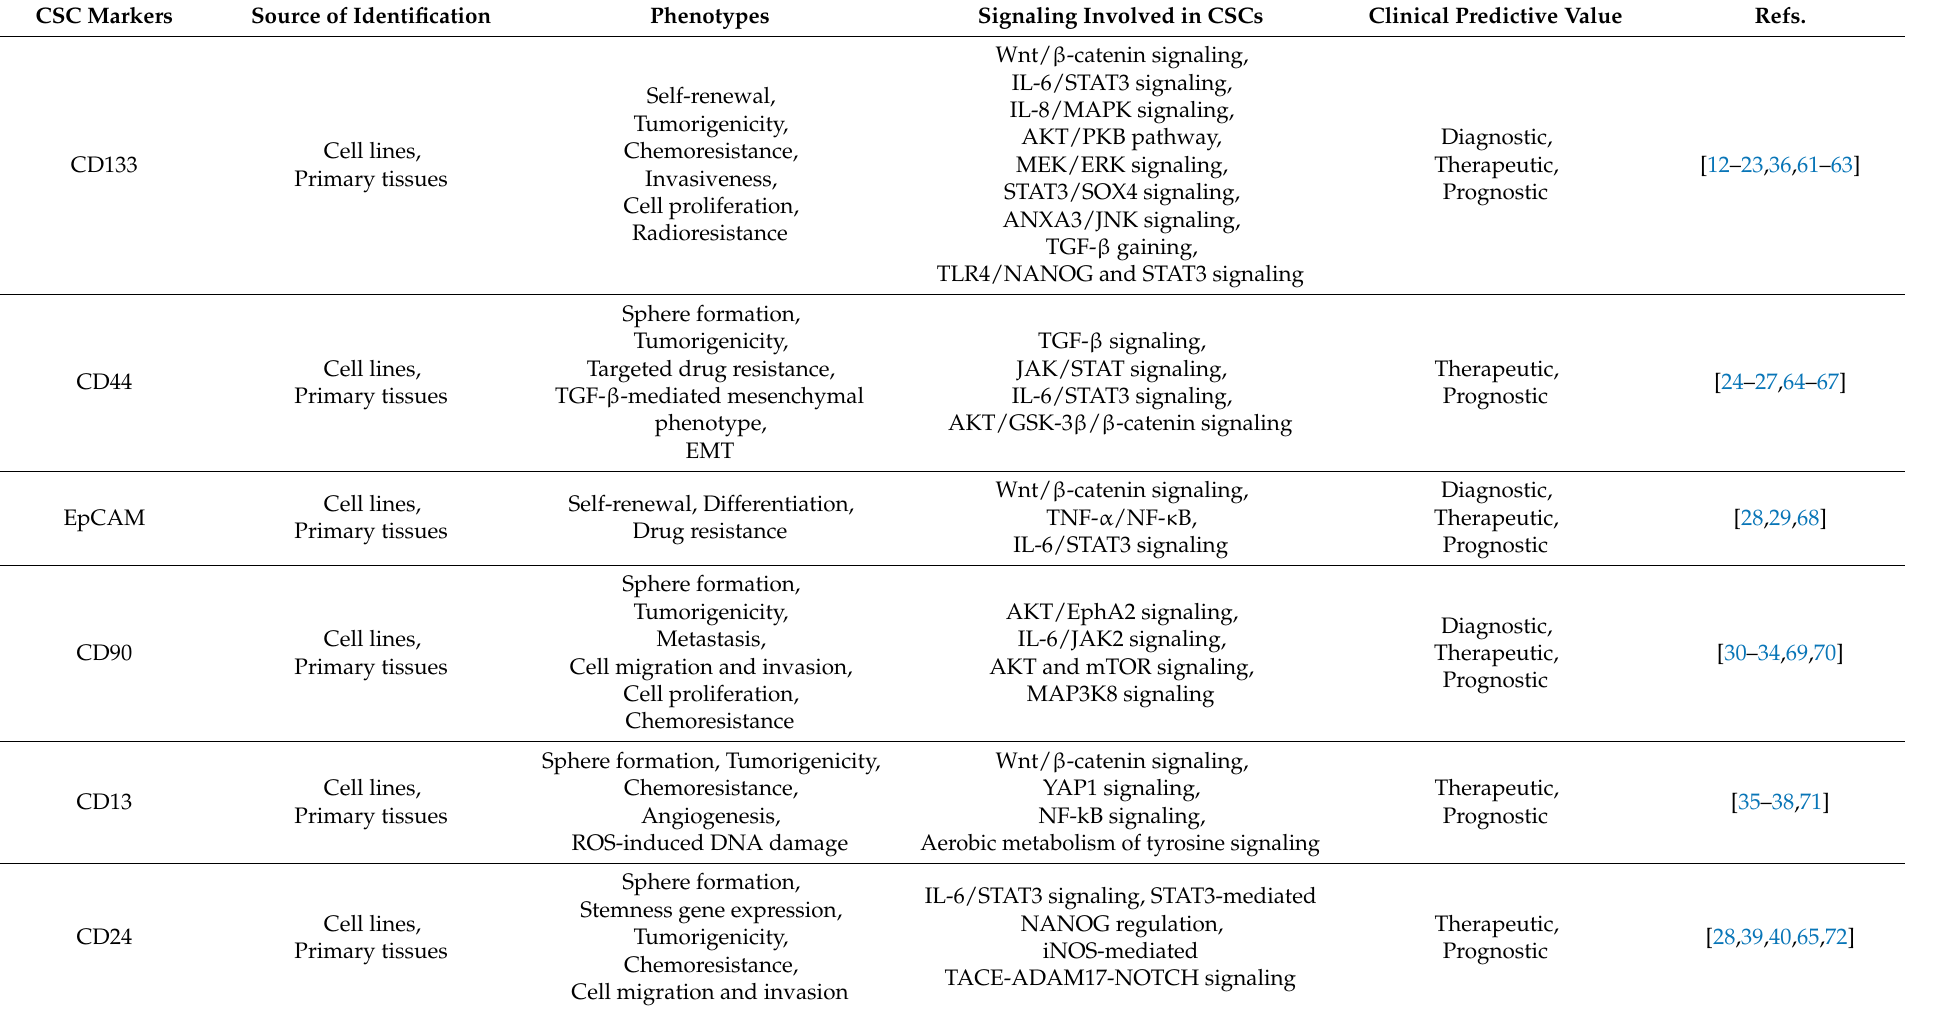
Table 1. Surface markers of hepatic